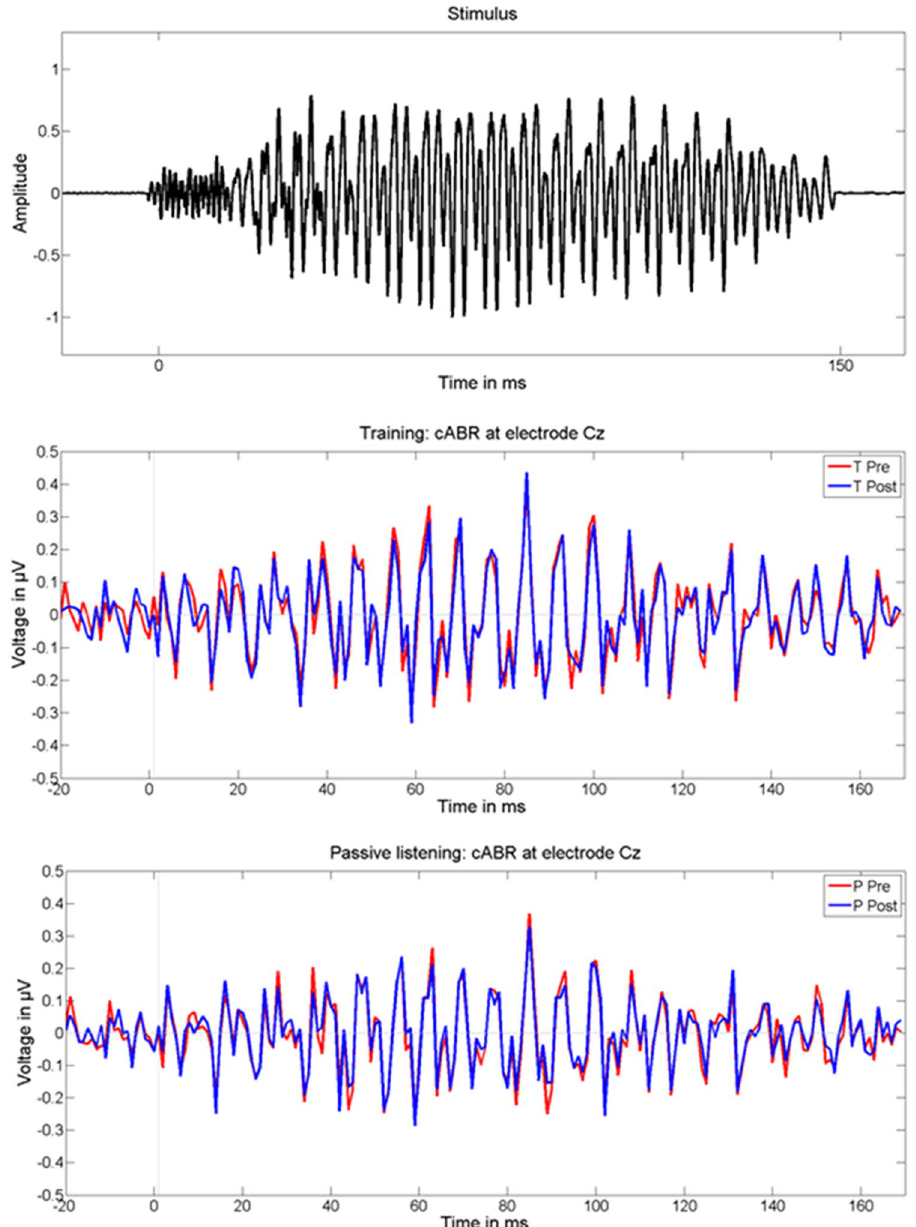
Figure 2. Stimulus waveform and FFRs (subtracted polarities). Top = stimulus waveform; middle = FFRs at T0 (pre, red line) and T1 (post, blue line) within the TG; bottom = FFRs at T0 (pre, red line) and T1 (post, blue line) within the